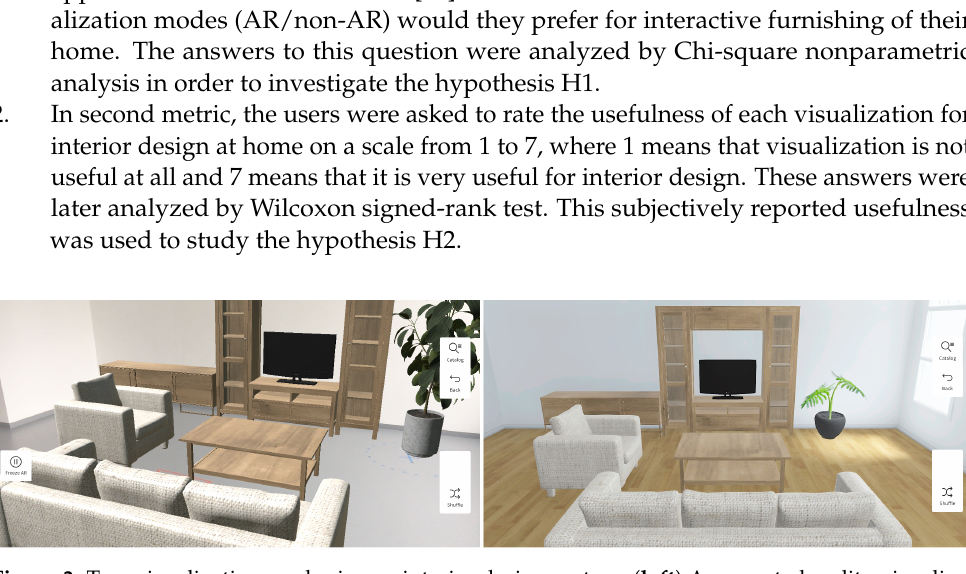
Figure 3. Two visualization modes in our interior design system: ( left ) Augmented reality visualiza- tion and ( right ) non-AR visualization in template 3D